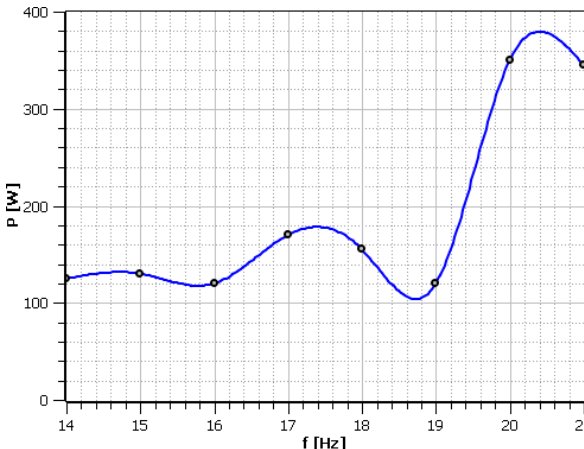
Figure 10: Minimum electrical power delivered to the extinguisher causing extinguishing effect in the function of sound frequency